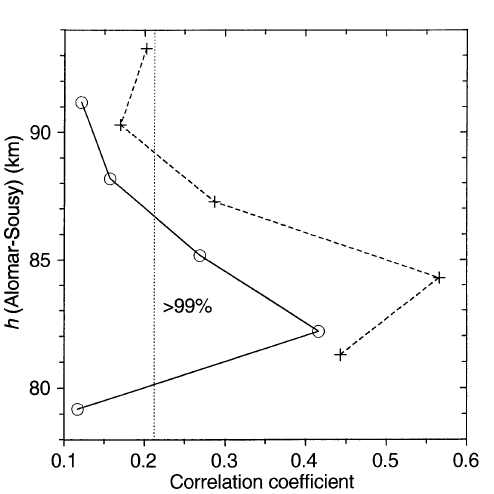
Fig. 9. Correlation between hourly SNR values deduced from EIS- CAT VHF and MF-radar observations as a function of height using SNR values at equal heights ( solid line ) and at different heights ( dashed line : h (EISCAT) " h (MF) # 2.5 km)